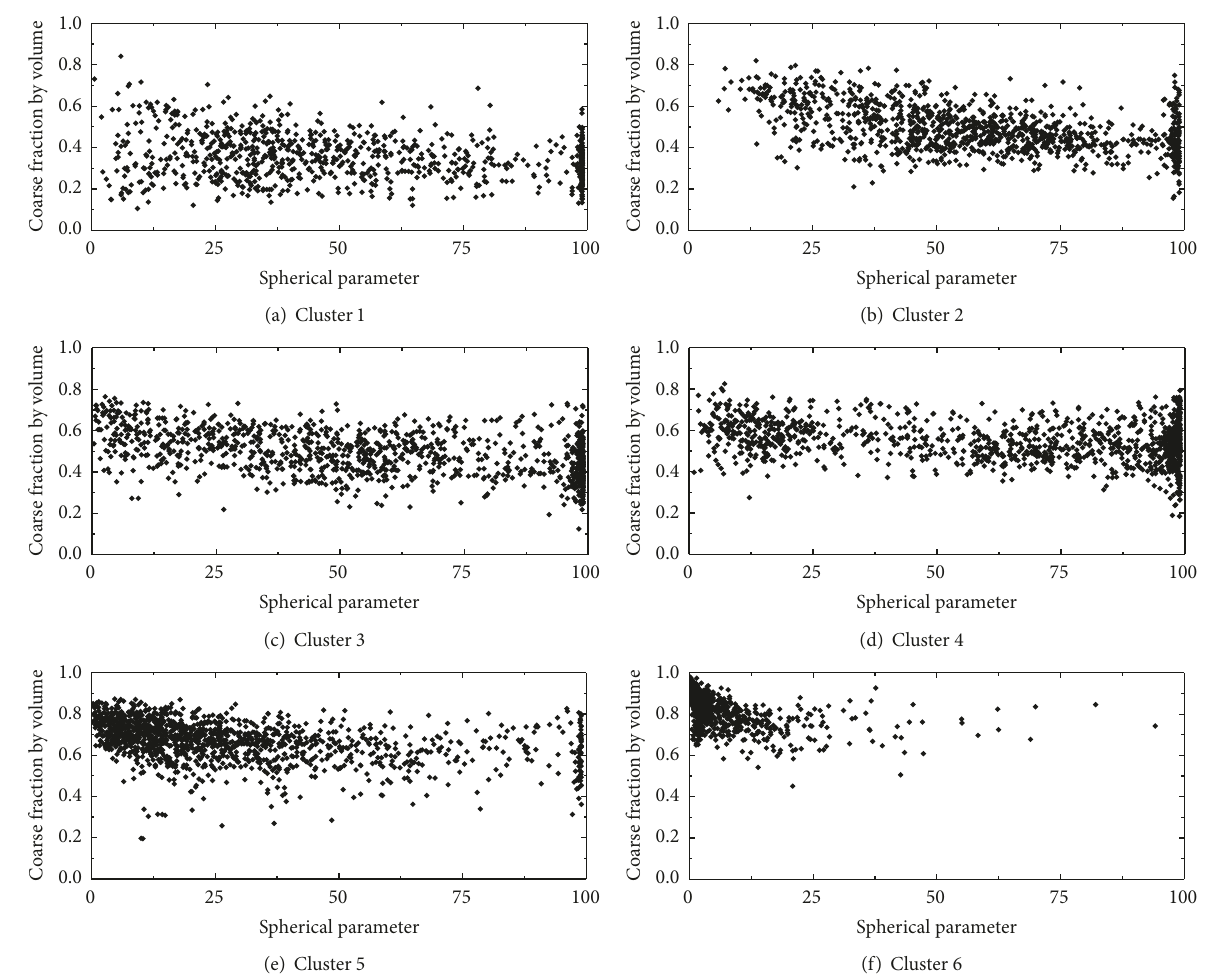
Figure 4: Relationships of sphericity parameter and coarse fraction by